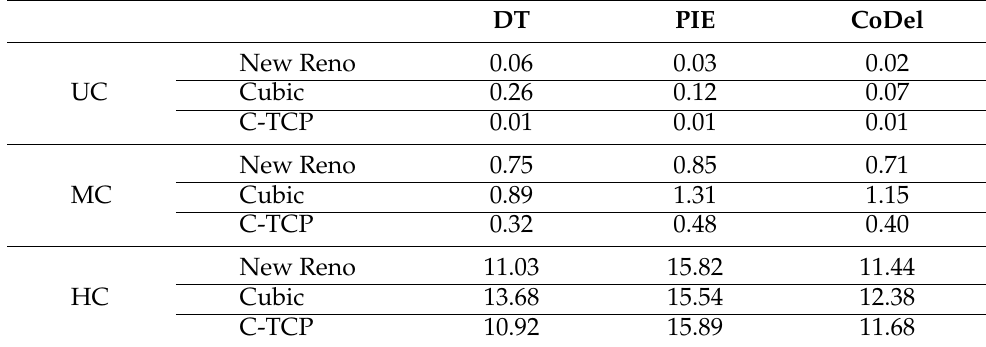
Table 9. Packet drop ratio [%] in the Access Link scenario with common TCPs, UC—uncongested, MC—mildly congested, HC—heavily congested